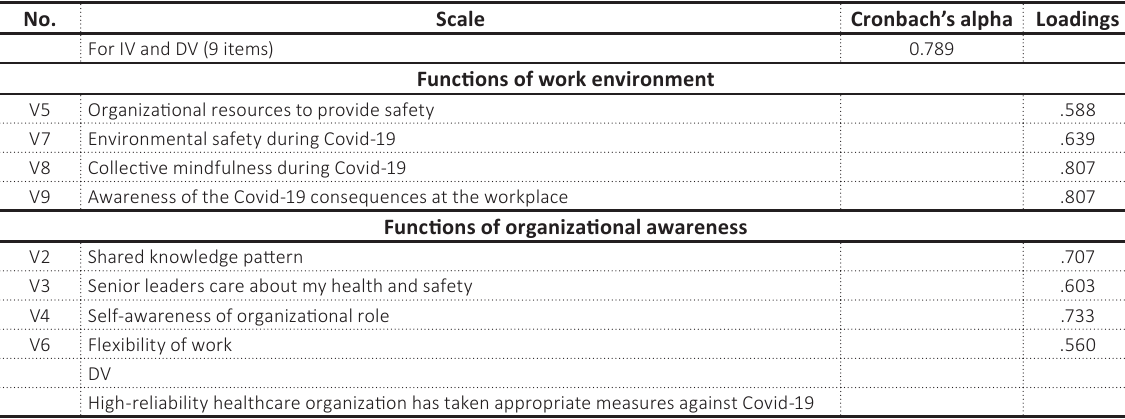
Table 3. Reliability